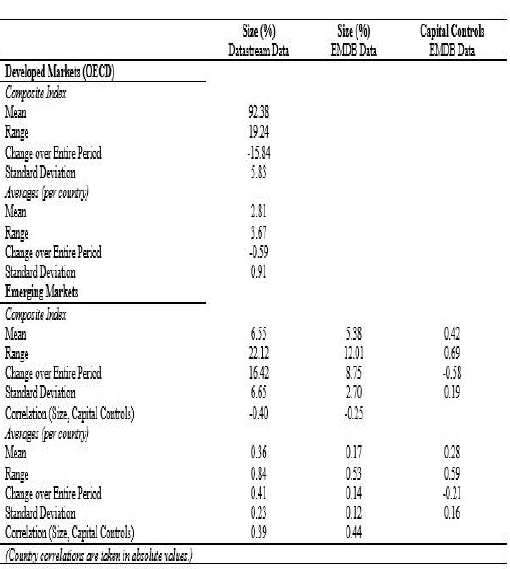
Table 3: Size and Segmentation Variables - Descriptive Statistics (DATASTREAM and EMDB